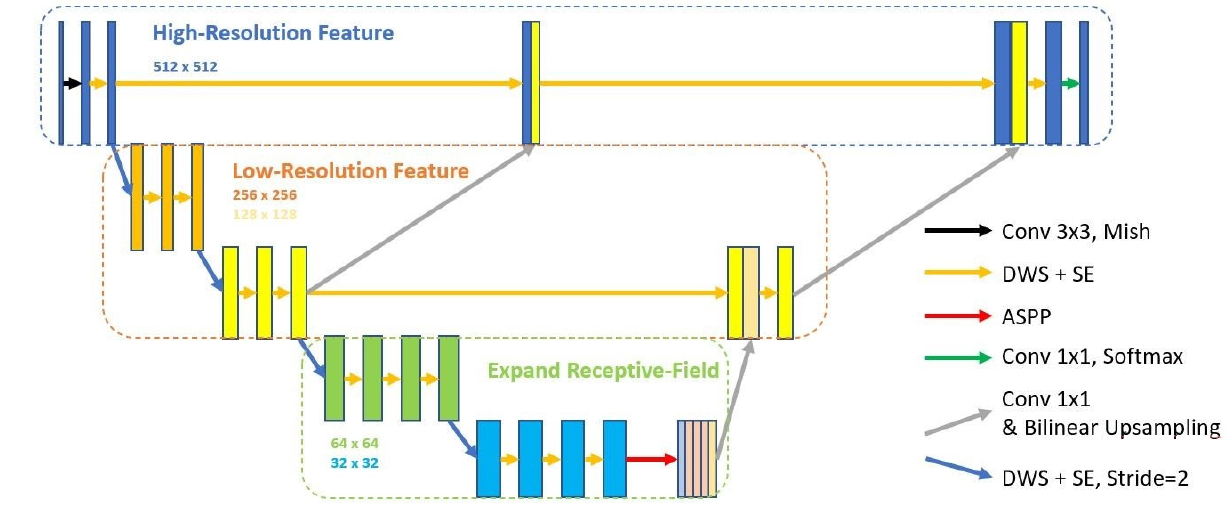
( e ) Figure 15. Comparison diagram of prediction results of various semantic segmentation models. ( a ) Input image; ( b ) Result of the UNet [43]; ( c ) Result of the PSPNet [44]; ( d ) Result of the HRNet [46]; ( e ) Result of the DeepLab v3+ [45] Besides basic convolution operation, the depthwise separable convolution, squeeze- and-excitation networks, and residual connection were used in this study’s deep learning semantic segmentation model. The entire model was divided into three main stages: high- resolution feature, low-resolution feature, and expanded receptive field feature, as shown in Figures 16 and 17. The expanded receptive field feature part employed dilated convo- lution and Atrous Spatial Pyramid Pooling to further enhance the receptive field of the